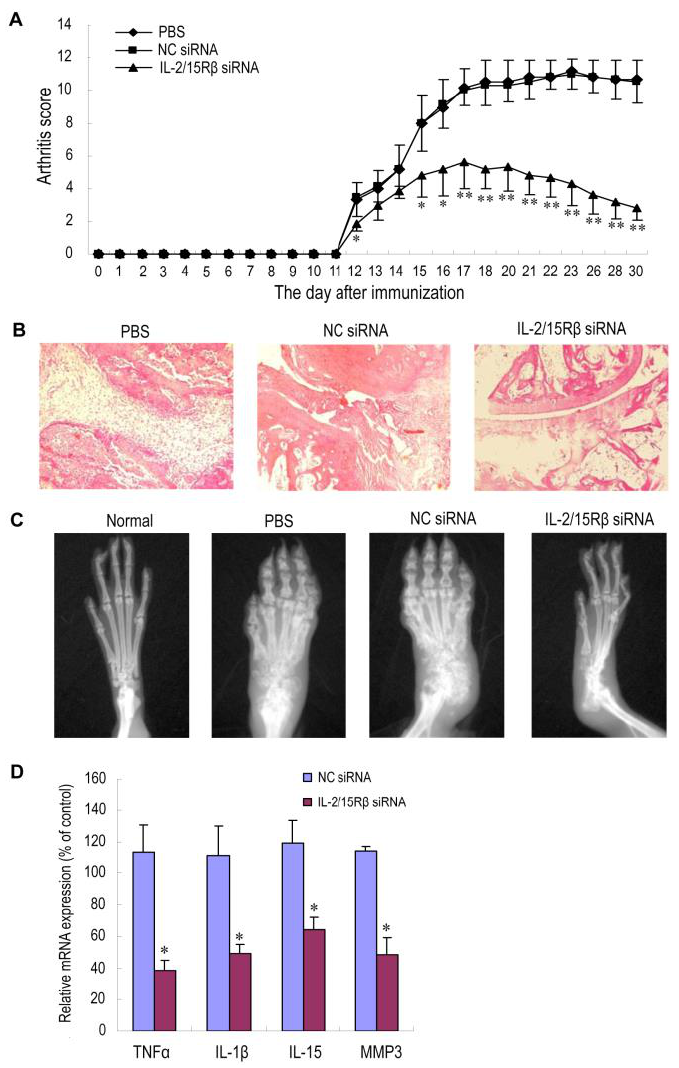
Figure 7. Therapeutic effects of PEI/IL-2/15R β siRNA complexes on AA rats. Male Wistar rats (n = 6 per group) were given Freund’s complete adjuvant in the left hind footpad on day 0. IL-2/15Rβ siRNA-5 polyplexes were intravenously administered on days 10, 17 and 24 at 0.3 mg siRNA/kg. The rats receiving NC siRNA polyplexes or PBS served as controls. ( A ) Arthritis score. Values are the mean and SD. * p < 0.05; ** p < 0.01, versus the PBS group. ( B ) Representative histopathologies of the right hind ankle joints stained with hematoxylin and eosin (H&E). Rats were sacrificed and subjected to histopathological examination on day 31. Minimal articular inflammation and joint de- struction were observed in the group treated with IL- 2/15Rβ siRNA polyplexes, whereas PBS- and NC siRNA-treated rats exhibited pronounced synovial hyperplasia, bone damage and joint space narrowing. ( C ) Representative radiographs of right hind paws (n = 3 per group). On day 31, the rats were anesthetized and subjected to radiography. Neither paw swelling nor joint damage was ob- served in normal rats. Severe bone erosion was seen in AA rats treated with either PBS or NC siRNA polyplexes, but the damage was much less in rats treated with IL- 2/15Rβ siRNA polyplexes. ( D ) Effects of IL- 2/15Rβ siRNA polyplexes on mRNA expression of inflammatory factors. At the end of the experiment (day 31), RNA was prepared from the right hind ankle joints of AA rats in each group. mRNA levels of each factor were determined by qPCR, normalized against GAPDH, and expressed as percentage of the PBS control. The result is presented as values (the mean and SD) obtained from three different samples randomly selected in each group. * p < 0.05, versus PBS con- trol. Reprinted with permission from Ref. [60] . Copyright © 2013 Zhang et al. 4.3. siRNA Blocking Pathways Pathways involved in the occurrence and progression of RA may be potential targets for RA gene treatment. However, it should be noted that the occurrence of RA results from the action of multiple signal pathways, and targeting only one pathway usually can not inhibit RA progression. Investigating each pathway thoroughly helps us connect them to